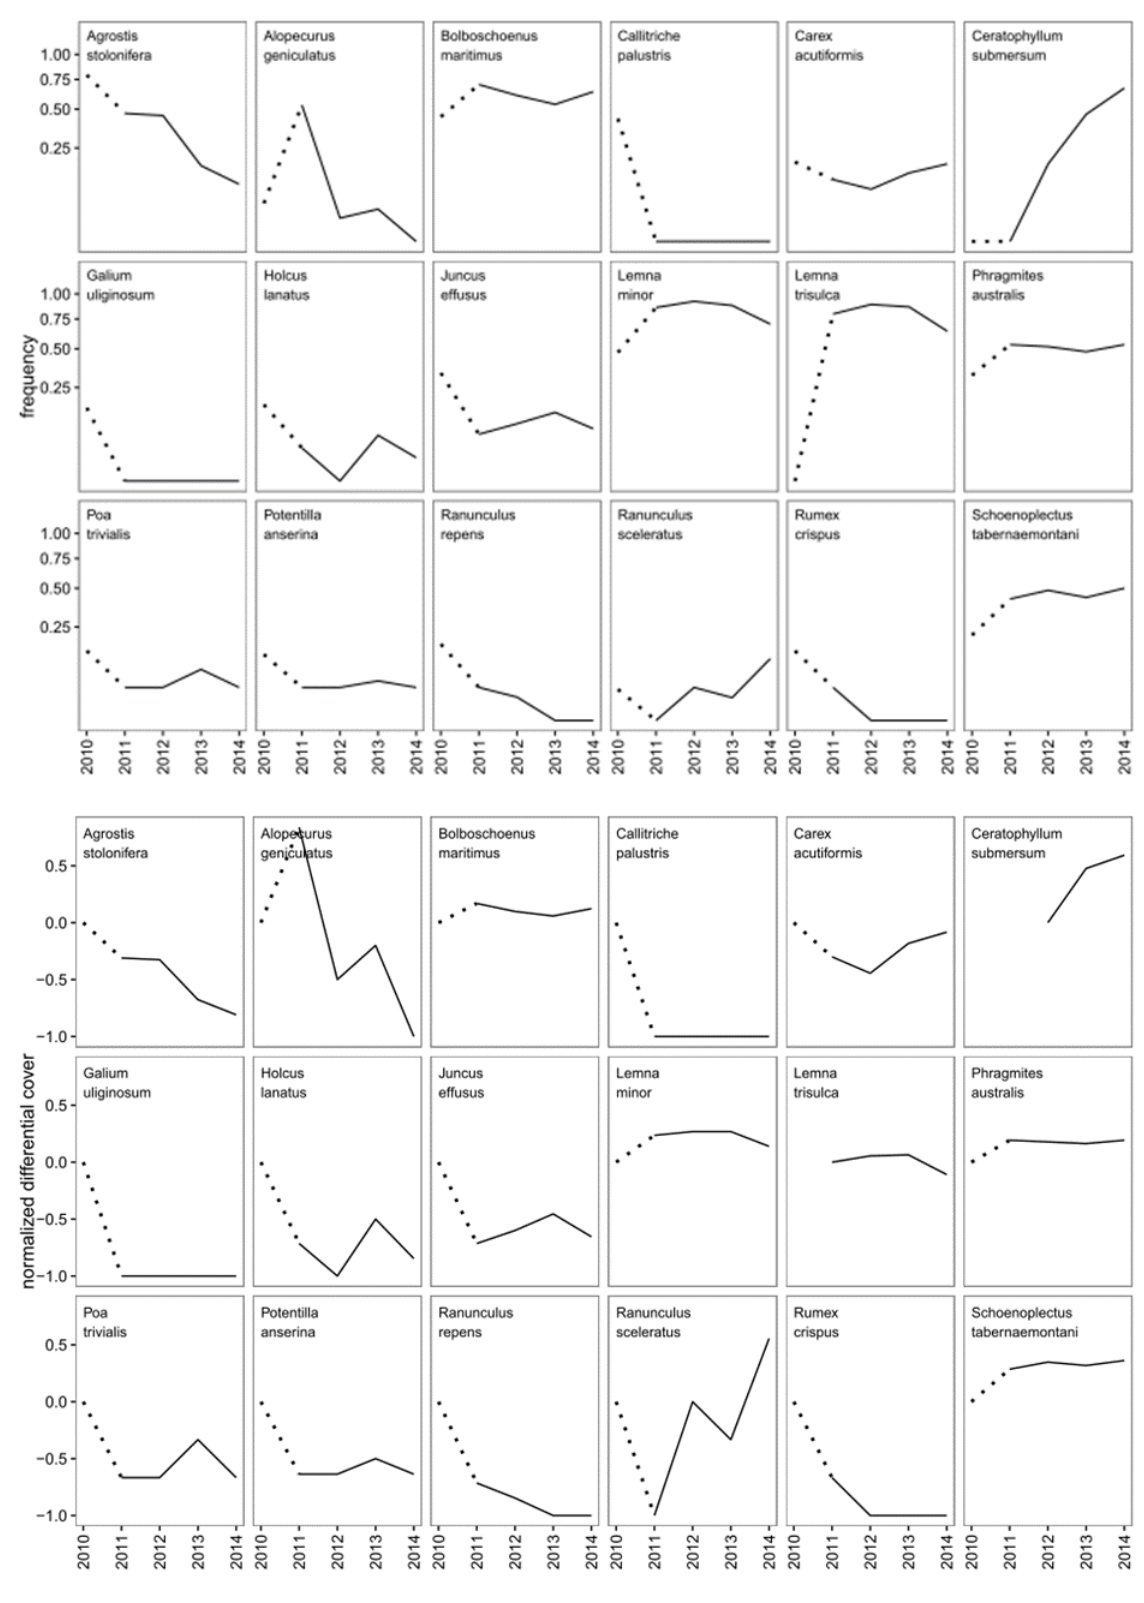
Figure 3. Development of species frequencies (a) and abundances (b) from 2011 to 2014 (normalised to the value in the year of first occurrence). Only the twelve species that underwent the greatest changes are